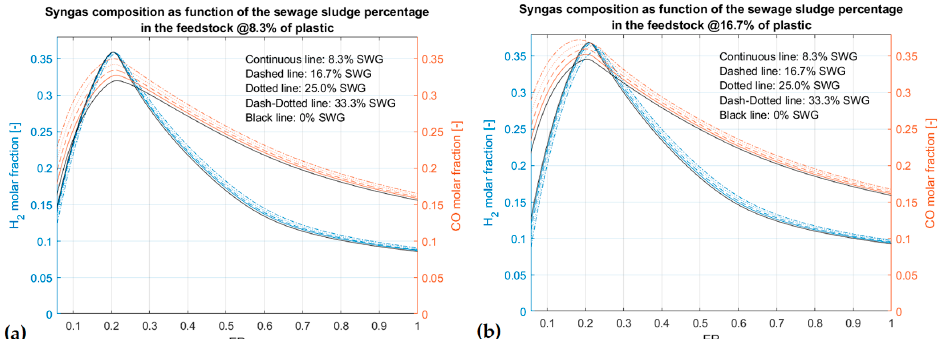
Figure 17. Mechanical power and combustion temperature as a function of the sewage fraction and combustion ER at ( a ) 8.3% of plastic and ( b ) 16.7% of plastic.